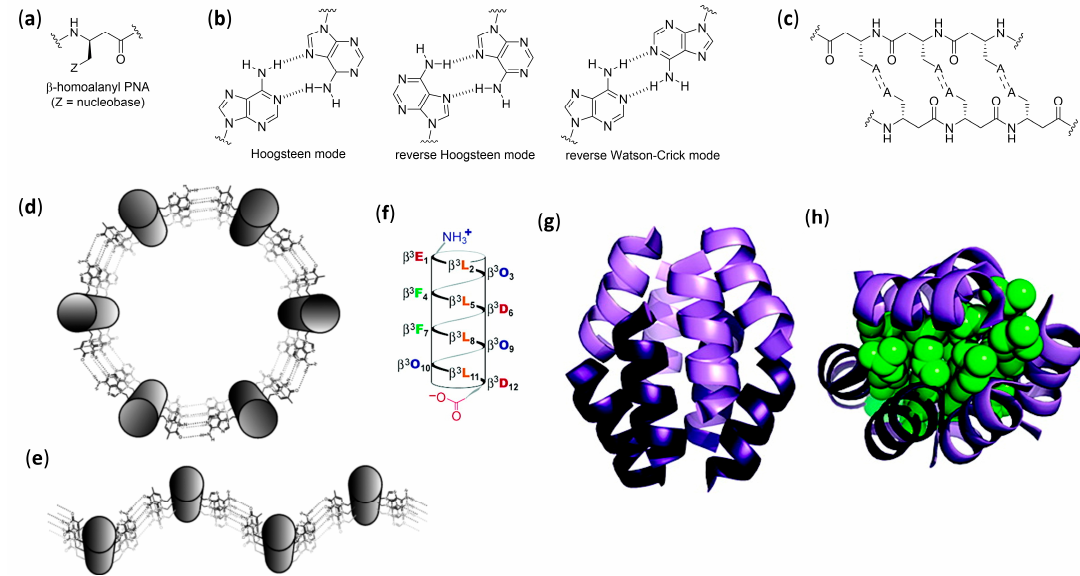
Figure 4. ( a ) A generic β -homoalanyl PNA (Refs. [84,85]); ( b ) Possible A-A pairing modes (Refs. [84,85]); ( c ) Beta-sheet-like antiparallel double strand structure of a generic adeninyl β -homoalanine foldamer (Refs. [84,85]); ( d ) Cyclic and ( e ) band-like modes of aggregation of two-side nucleobase-functionalized β -peptide 14-helices (helices reported as cylinders) (adapted with permission from Ref. [91]); ( f ) Cylinder representation of foldamer Zwit-1F ( β 3 -amino acids indicated using the single-letter codes of the corresponding α -amino acids. β 3 O = β 3 -homoornithine) (adapted with permission from Ref. [96]); ( g ) Ribbon representation of octameric bundle of foldamer Zwit-1F, together with ( h ) its tightly packed hydrophobic core ( β 3 -homoleucine side chains are shown in space-filling representation) (adapted with permission from Ref. [96]).